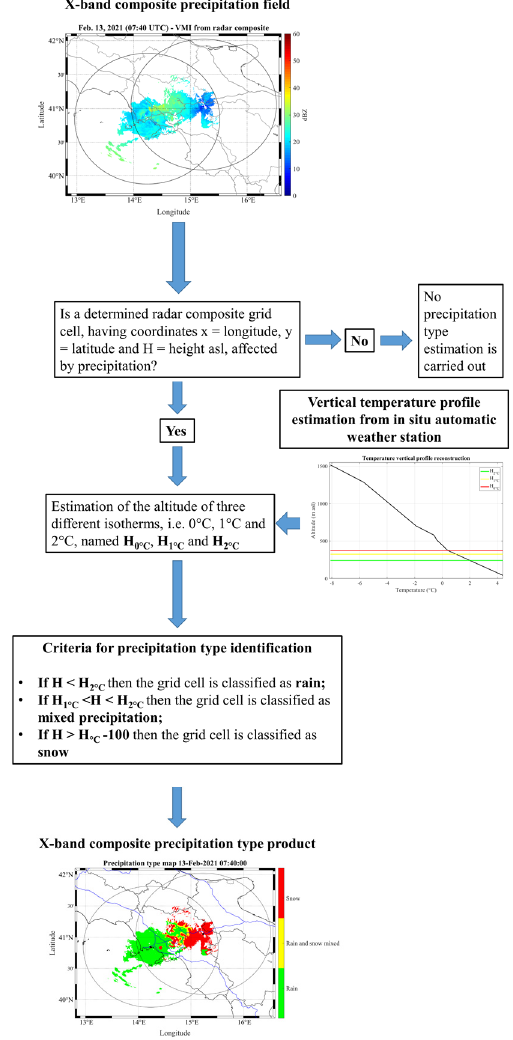
Figure 7. Schematic diagram of precipitation type product generation. The process starts from the composite precipitation field (expressed in terms of vertical maximum intensity). If a determined grid cell is affected by precipitation, it is assigned to a precipitation type category (rain, mixed precipitation and snow) according to the vertical temperature profile estimated from in situ automatic weather station measurements for the four different sub-regions sketched in Figure 6.